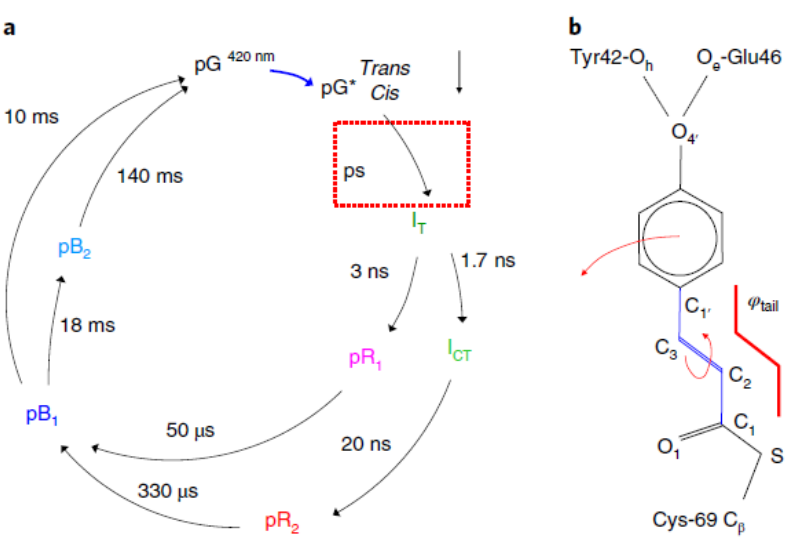
Figure 15. The photocycle of PYP in crystals. ( a ) The photocycle is initiated by blue light that excites the ground (dark) state pG to the electronic excited state pG *; I T , pR 1 , pR 2 , pB 1 and pB 2 , denote various intermediate states. ( b ) The chemical structure of the trans configuration of the pCA chromophore bound to the Cys 69 sulfur. Figure reproduced with permission from Pandey et al. [139]. Copyright (2020) Springer Nature; access provided by the U.S. DOE PAGES public repository under the entry No. 1605212.